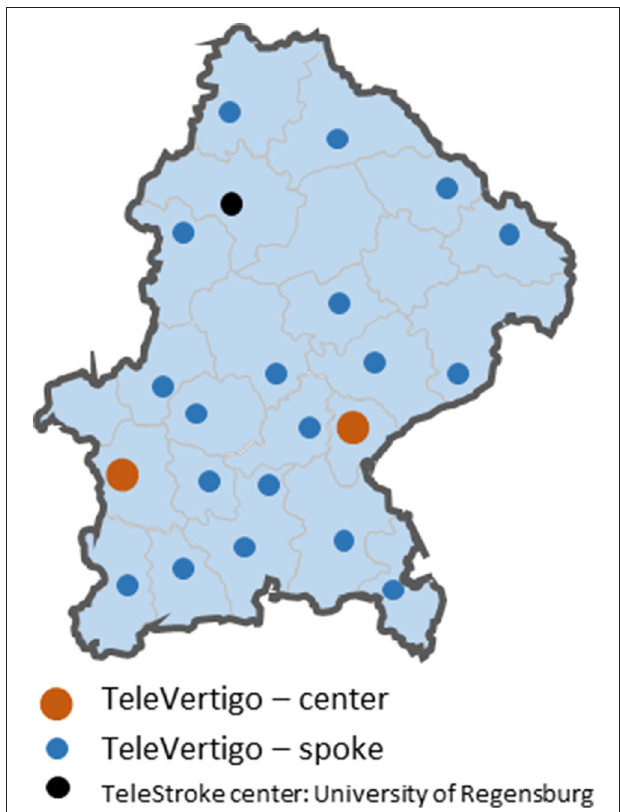
FIGURE 1 | Map of the southeastern part of Bavaria, Germany with all TeleVertigo